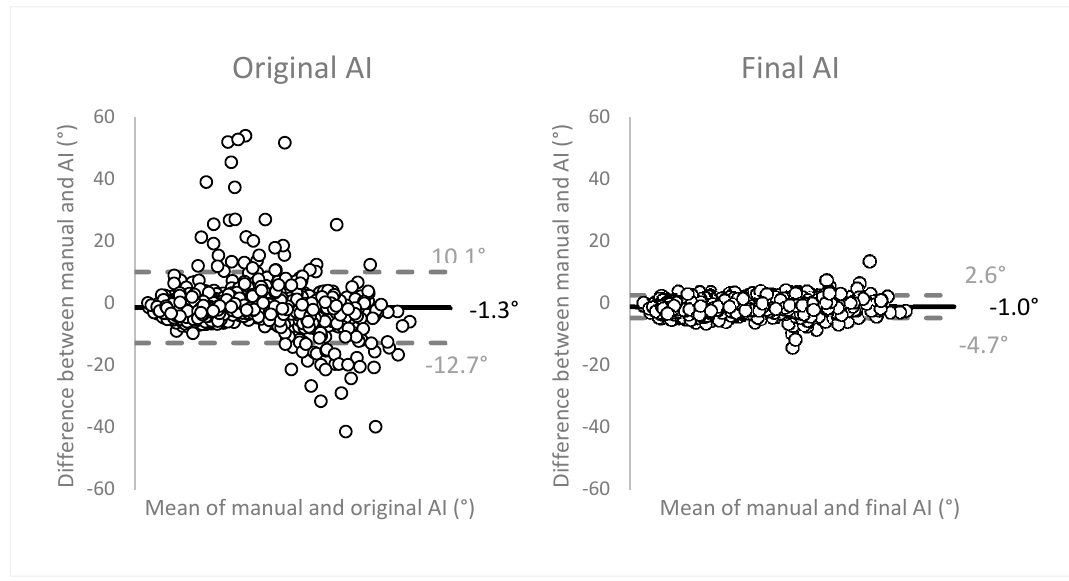
Figure 7. Bland–Altman plots showing good, unbiased agreement between manual and AI molar angulation measurements. Solid line representing the mean, dashed lines representing the upper and lower levels of agreement (mean ± 1.96 SD). Limits of agreement were narrow, translating as high precision of the method of